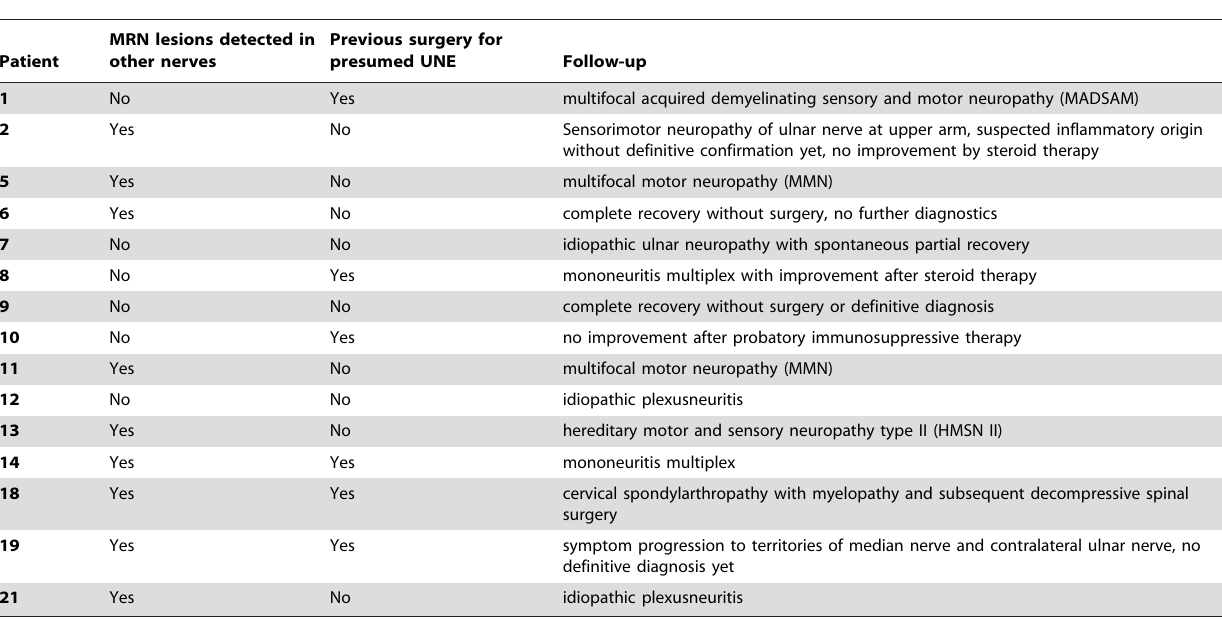
Table 2. Results for patients regarding the three endpoints of (i) presence of other subclinical nerve lesions, (ii) previous elbow surgery, and (iii) results of clinical